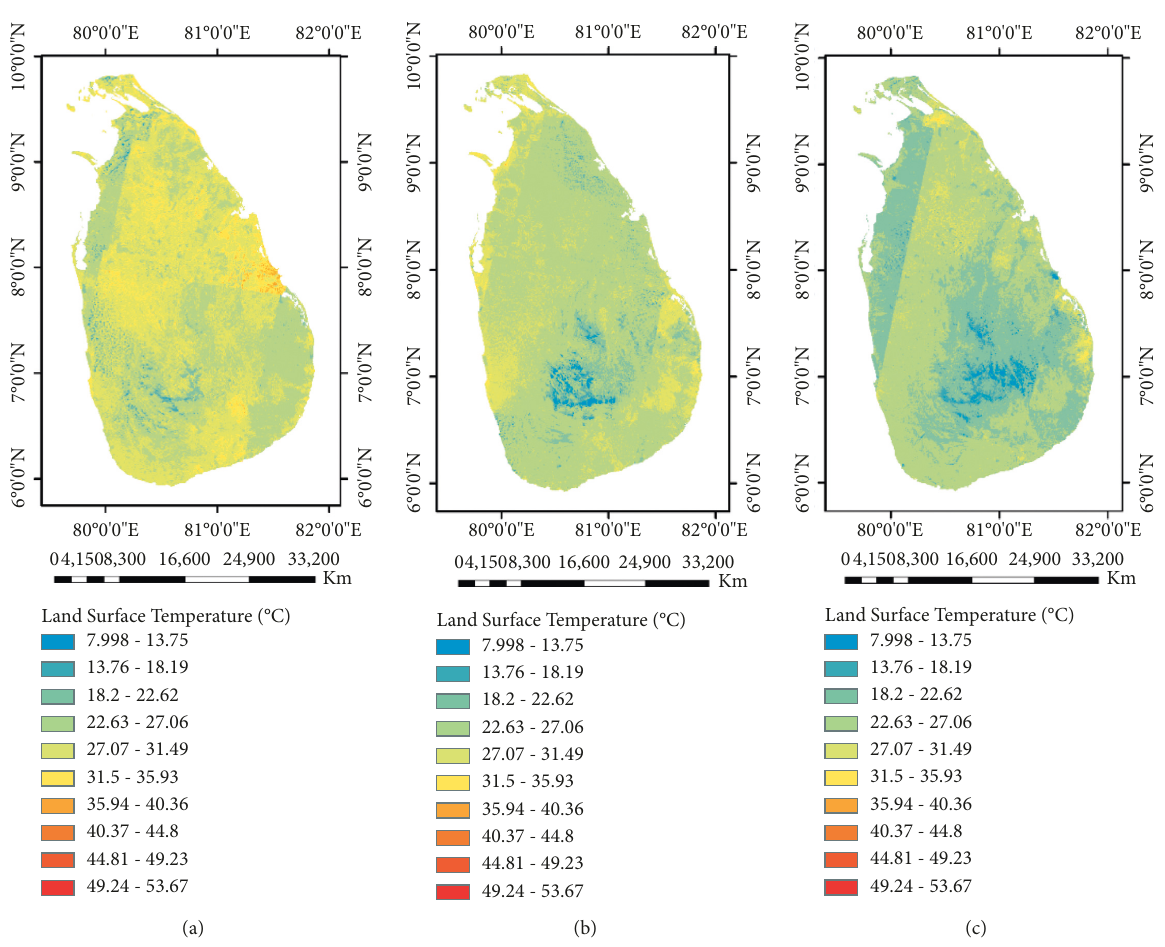
Figure 7: Land surface temperatures (LST) over the years. (a) For 2000. (b) For 2010. (c) For